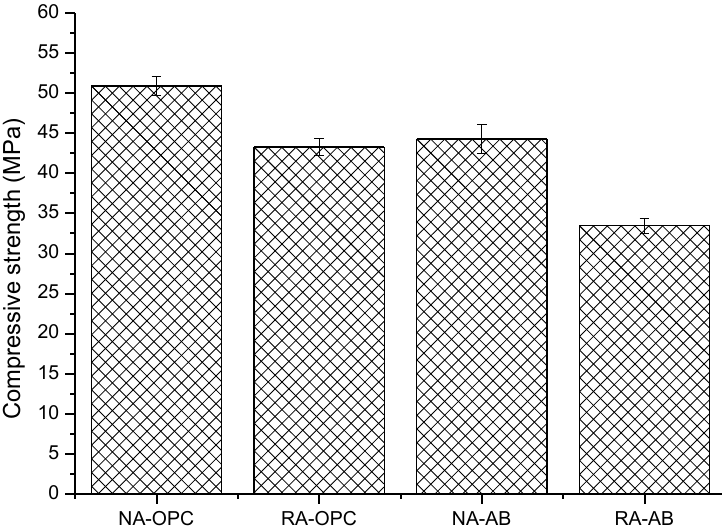
Figure 2. Compressive strength of concrete specimens. Standard deviation is plotted as error bars.